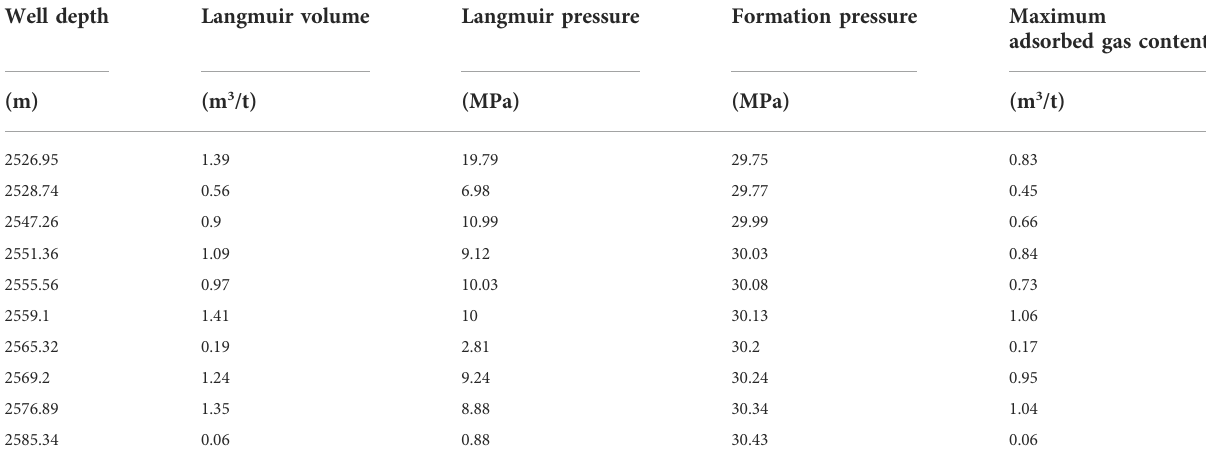
TABLE 2 Results of isothermal adsorption experiment and calculation results of formation pressure and maximum adsorbed gas content in Lianggaoshan Formation of Well TYX. Well